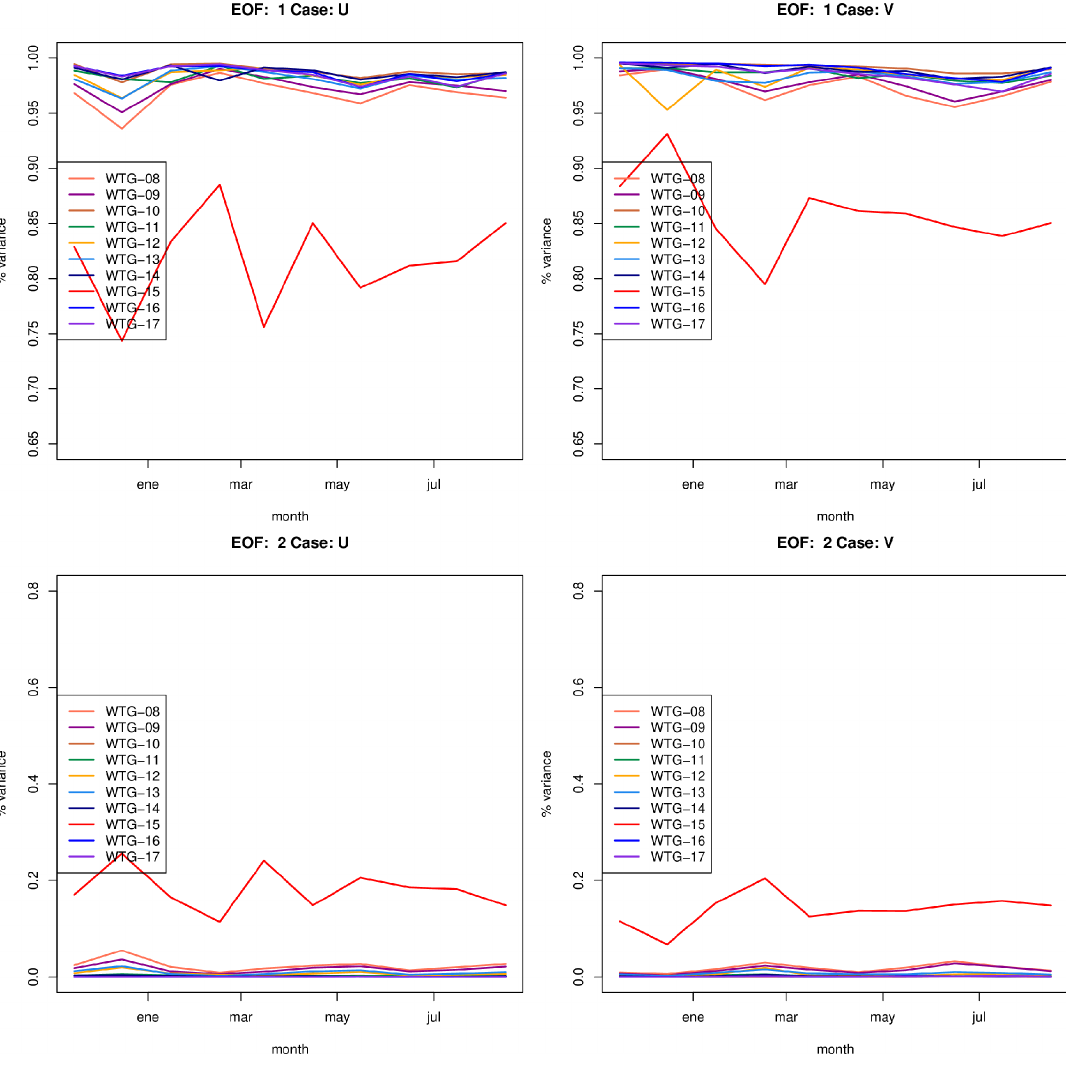
Figure 8. Principal components (leading, top row, and second, bottom row) of the zonal (left column) and meridional (right column) wind components for the anemometers in the wind farm, expressed as the fraction of variance explained at every anemometer by each principal component. EOF: empirical orthogonal